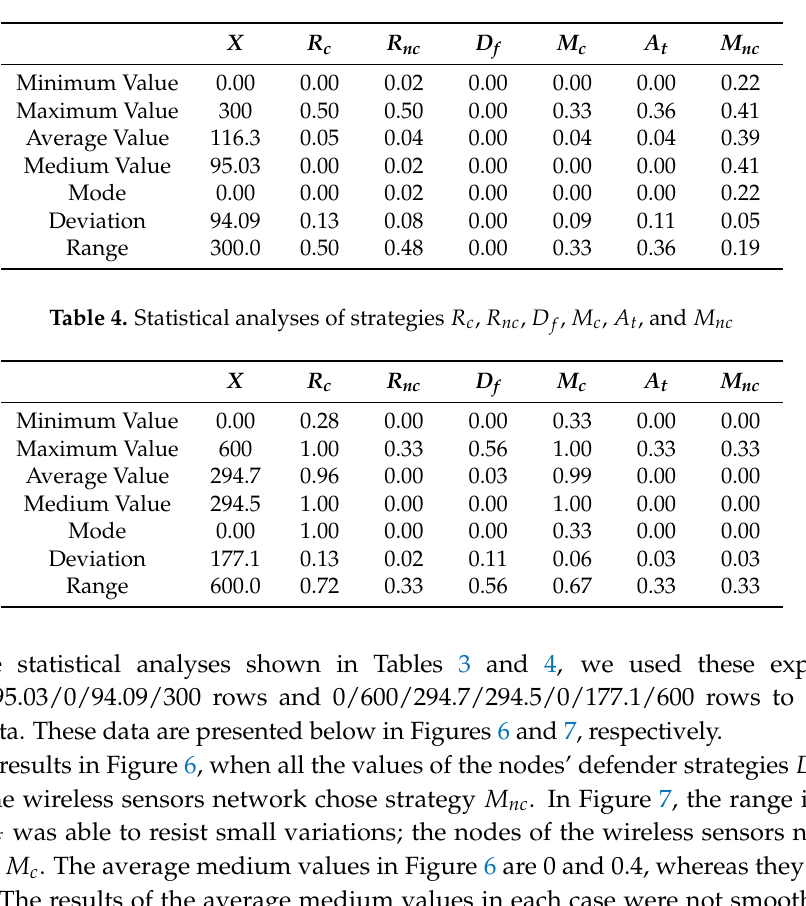
Figure 7. Analyses half of rational nodes when choosing defender strategies. From the results in Figure 6, when all the values of the nodes’ defender strategies f D